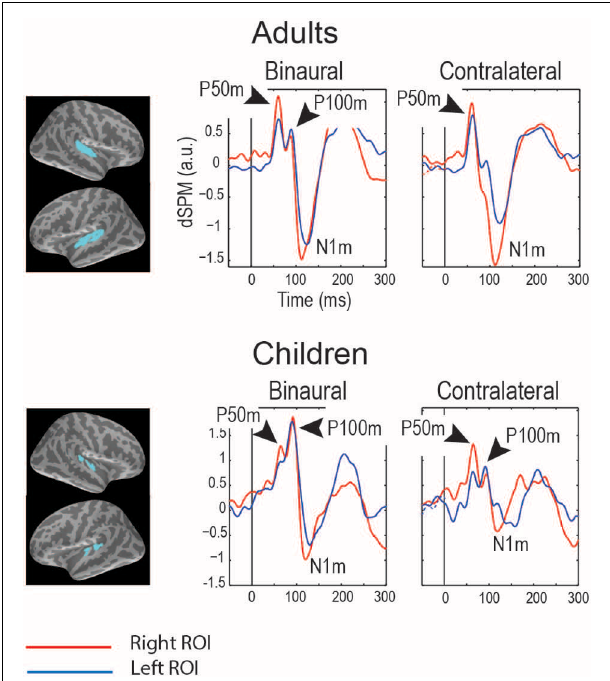
FIGURE 2 | Grand average magnetic auditory responses to binaural and monaural “S1” clicks in “neuro-typical” adults and children (8–15 years). The S1 click was presented after a long and variable interval (7–10s) and was followed by the S2 click after 1s. MEG source-specific dSPM time courses are given for the superior temporal regions (blue labels, see Orekhova et al., 2013, Figure 6 for details). The negative sign signifies incoming current and the positive sign signifies outgoing current. Note two distinct positive peaks of activity preceding N100m: P50m and P100m. The P50m is seen in both children and adults, while P100m is more prominent in children, especially in response to binaural clicks. The figure is adapted from Orekhova et al. (2013) with